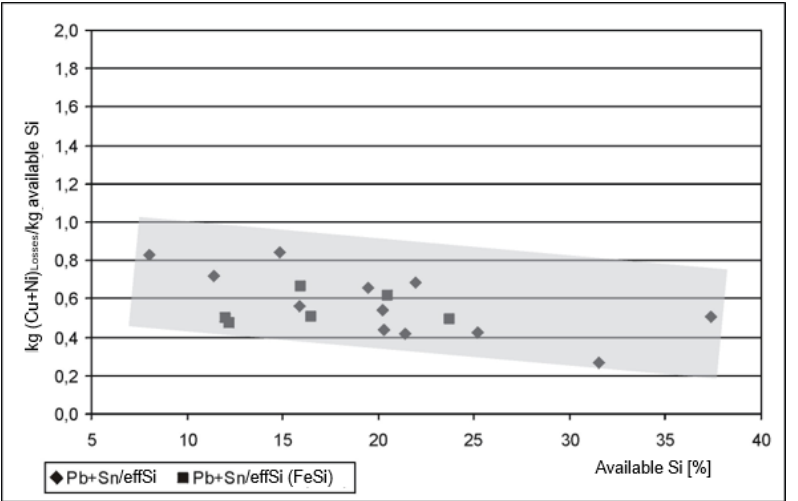
Figure 12. Specific lead and tin losses in the silicide product per kg of “available” silicon as a function of “available” silicon.